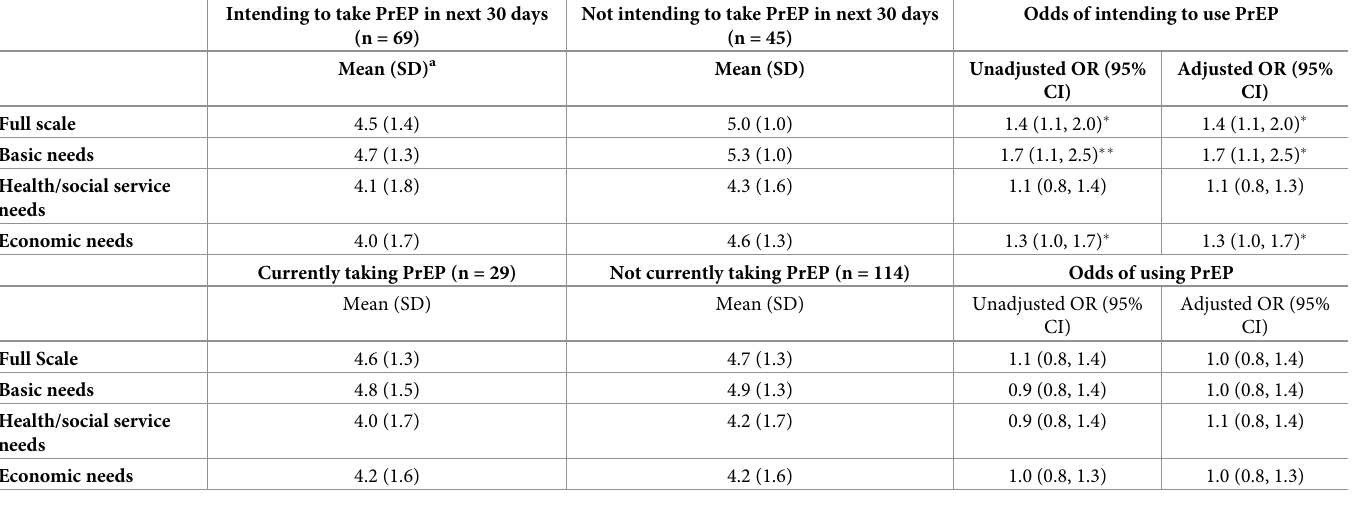
Table 2. Association of SDOH needs with both intention to use PrEP and current PrEP